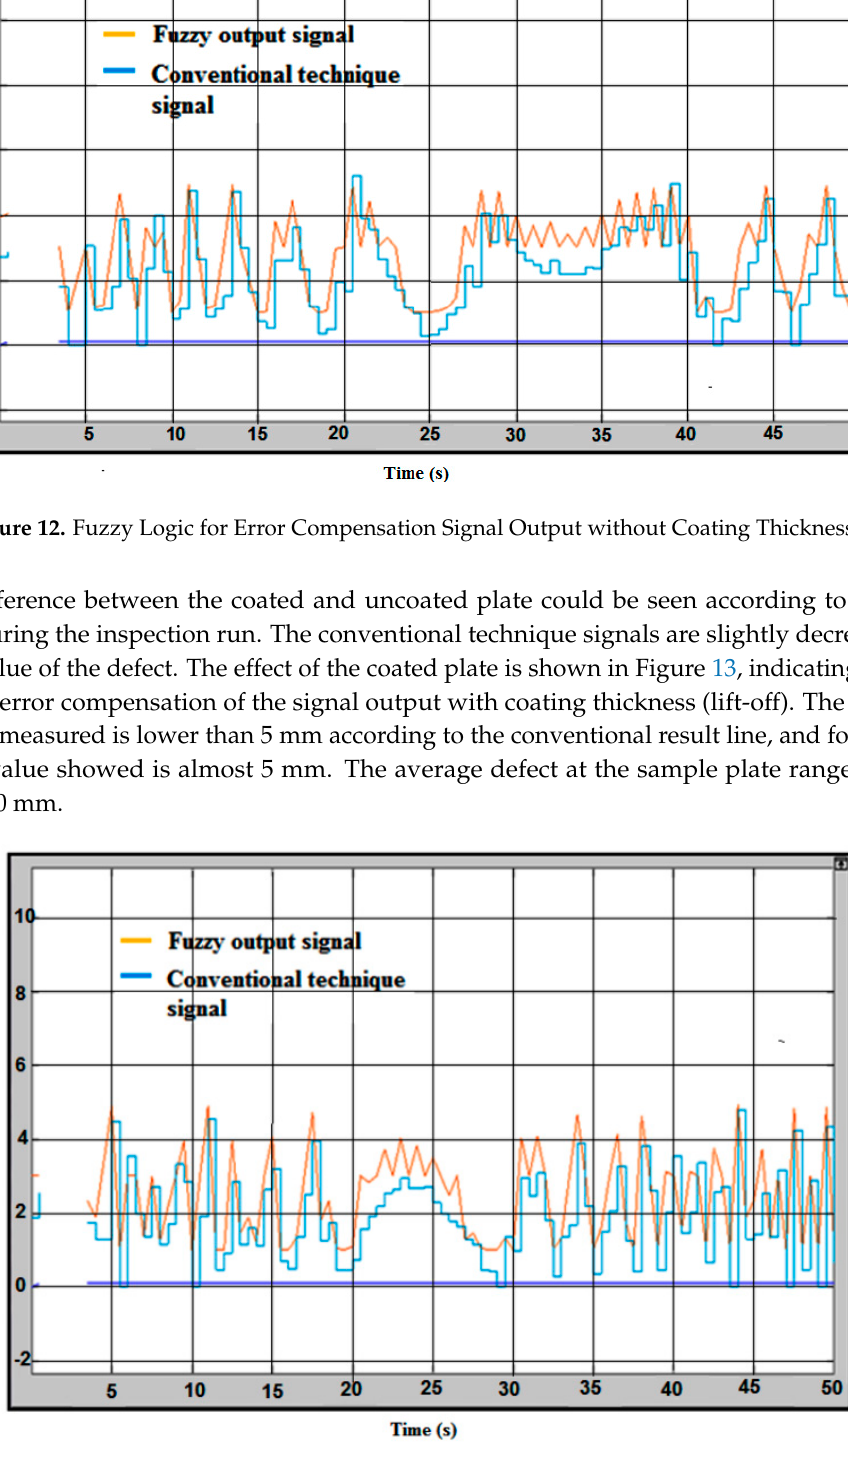
Table 4. Comparison of liftoff with different coating thickness. Liftoff (mm)